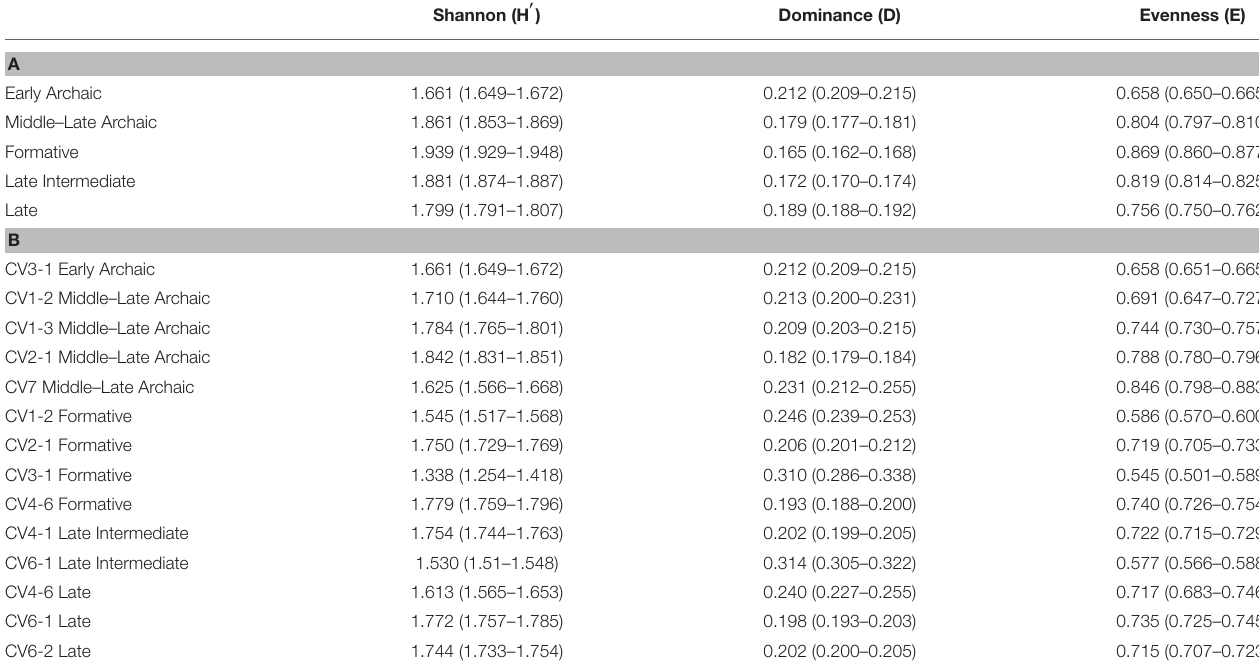
TABLE 4 | Diversity indices for shellfish assemblages computed across different cultural periods (A) and for each site and trench (B) . ′ Shannon (H ) Dominance (D) Evenness